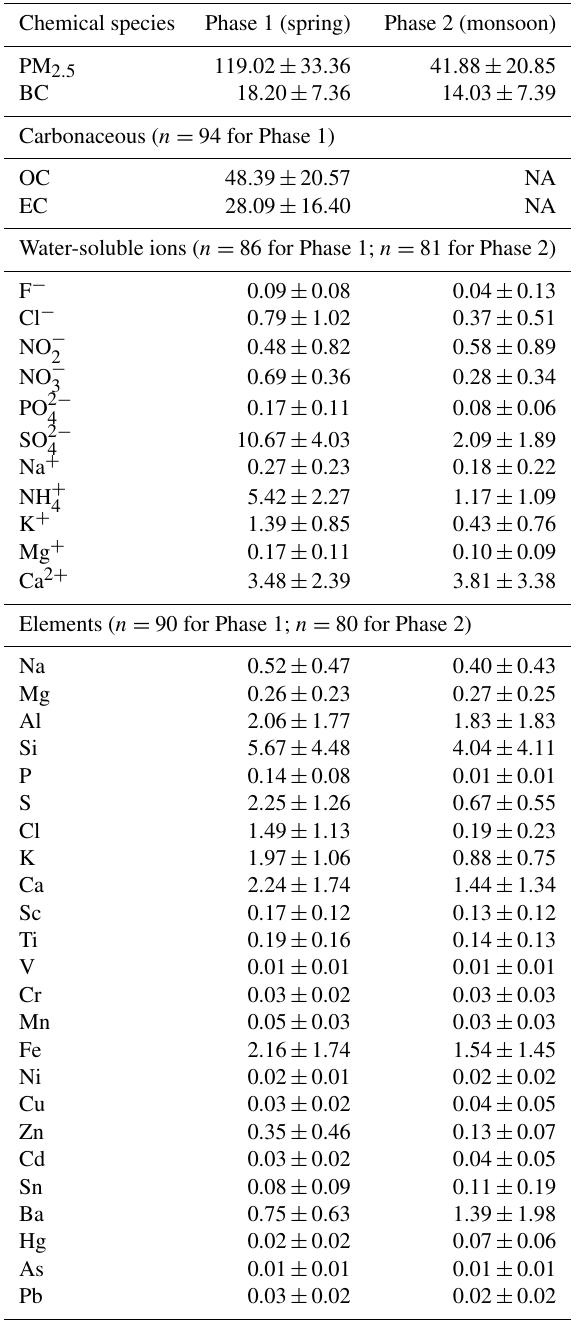
Table 1. Summary of PM 2 . 5 chemical composition (µgm − 3 ) in the Kathmandu Valley during the spring season (Phase 1) and monsoon season (Phase 2).